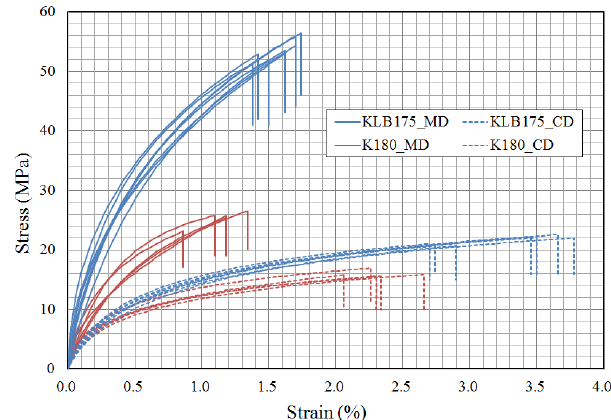
Figure 10. In-plane tensile S-S curves for the linerboards and the corrugating mediums of target corrugated paperboard.